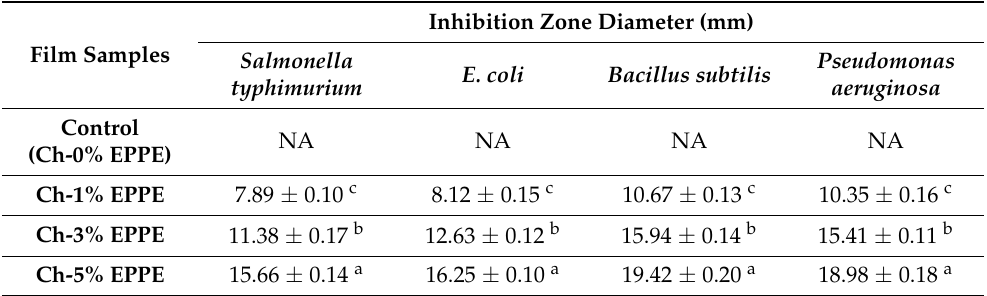
Table 5. Antibacterial activity of chitosan films modified with different percentages of